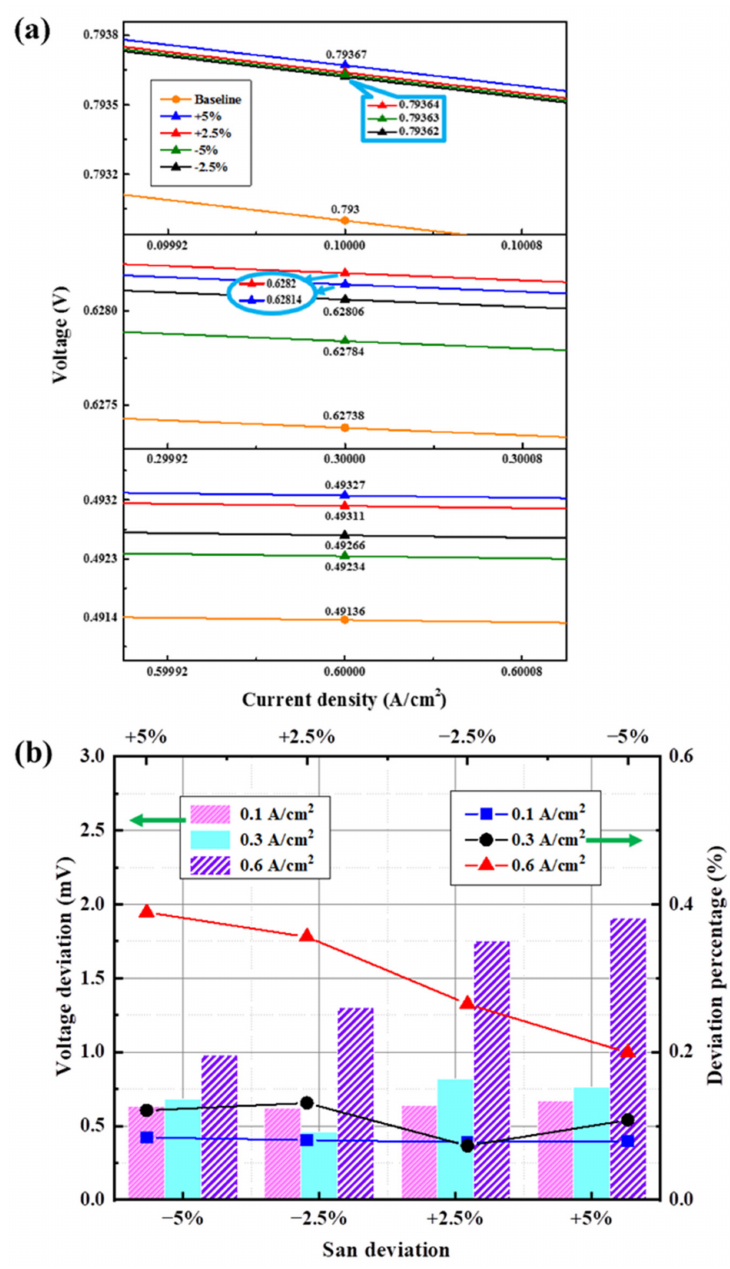
Figure 6. Impact of AMFR deviation on voltage: ( a ) polarization curves of different anode mass flow rate, ( b ) the voltage deviation obtained by AMFR deviations and their corresponding percentages under three current